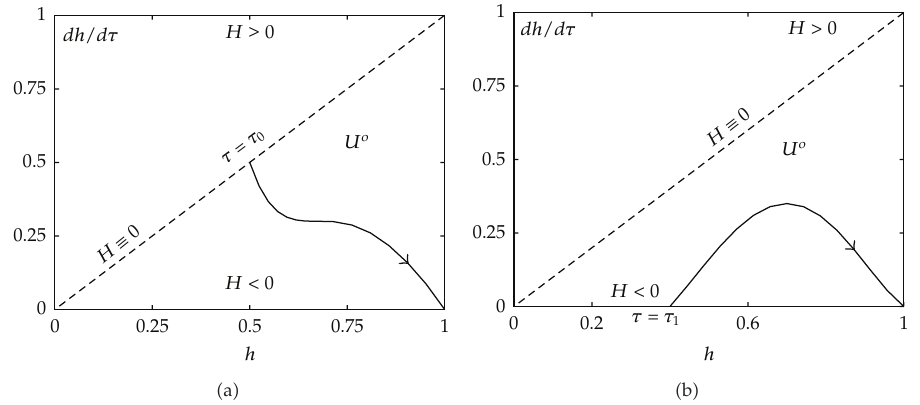
Figure 3: (cid:3) a (cid:4) solid curve illustrates properties (cid:3) 2.22 (cid:4) . (cid:3) b (cid:4) solid curve illustrates properties (cid:3) 2.25 (cid:4) and (cid:3) 2.26 (cid:4)